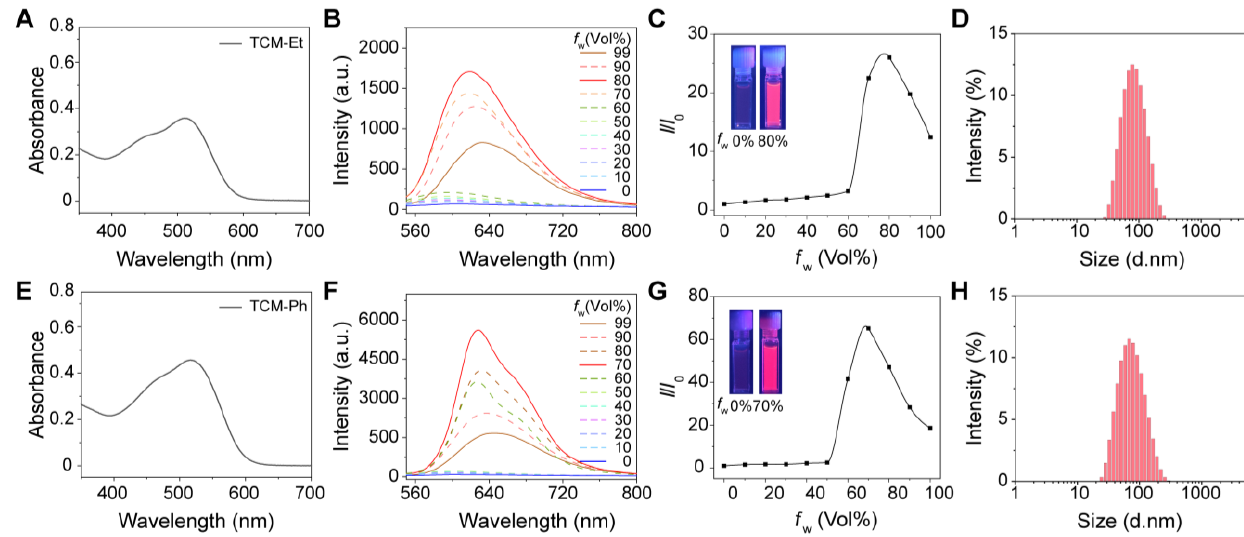
Figure 2. Photophysical properties of TCM-Et and TCM-Ph. ( A ) Absorption spectra of TCM-Et in 99% water; ( B ) Fluorescence spectra and ( C ) I / I 0 plots of TCM-Et in THF/water mixtures with different water fractions ( f w ), λ ex = 511 nm. Inset: photographs of TCM-Et in 0% and 80% water under UV lamp (365 nm). I 0 is the maximum fluorescence intensity of TCM-Et in THF. ( D ) Size distribution of TCM-Et in 99% water; ( E ) Absorption spectra of TCM-Ph in 99% water; ( F ) Fluorescence spectra and ( G ) I / I 0 plots of TCM-Ph in THF/water mixtures with different f w , λ ex = 510 nm. Inset: photographs of TCM-Ph in 0% and 70% water under UV lamp (365 nm). I 0 is the maximum fluorescence intensity of TCM-Ph in THF. ( H ) Size distribution of TCM-Ph in 99% water.